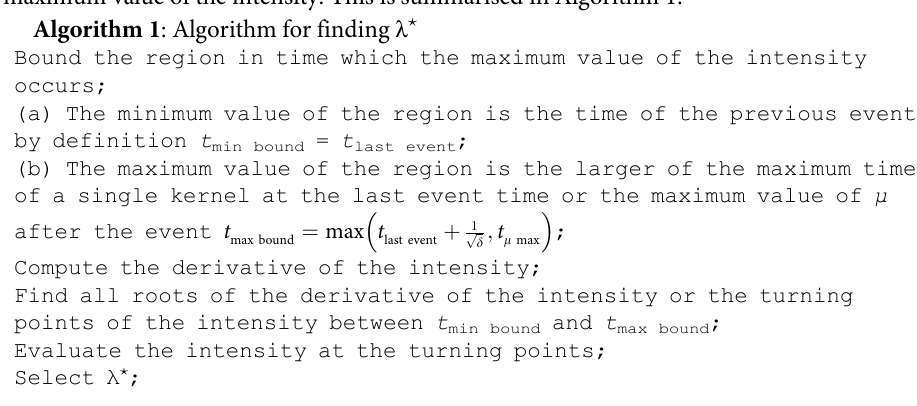
Algorithm 1 : Algorithm for finding λ